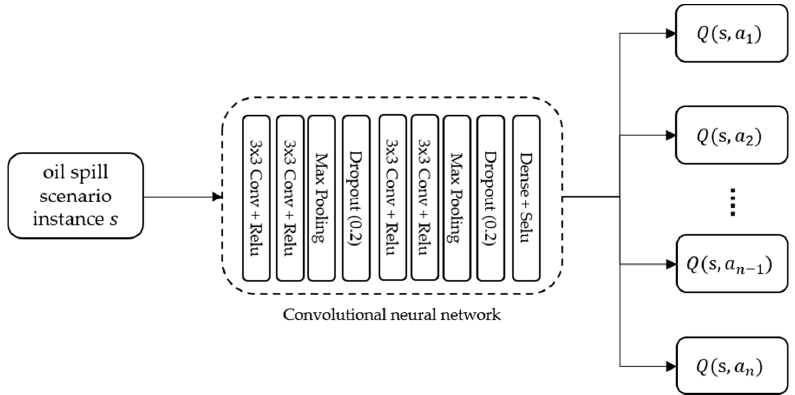
Figure 2. The input and output of the approximator based on the neural network.